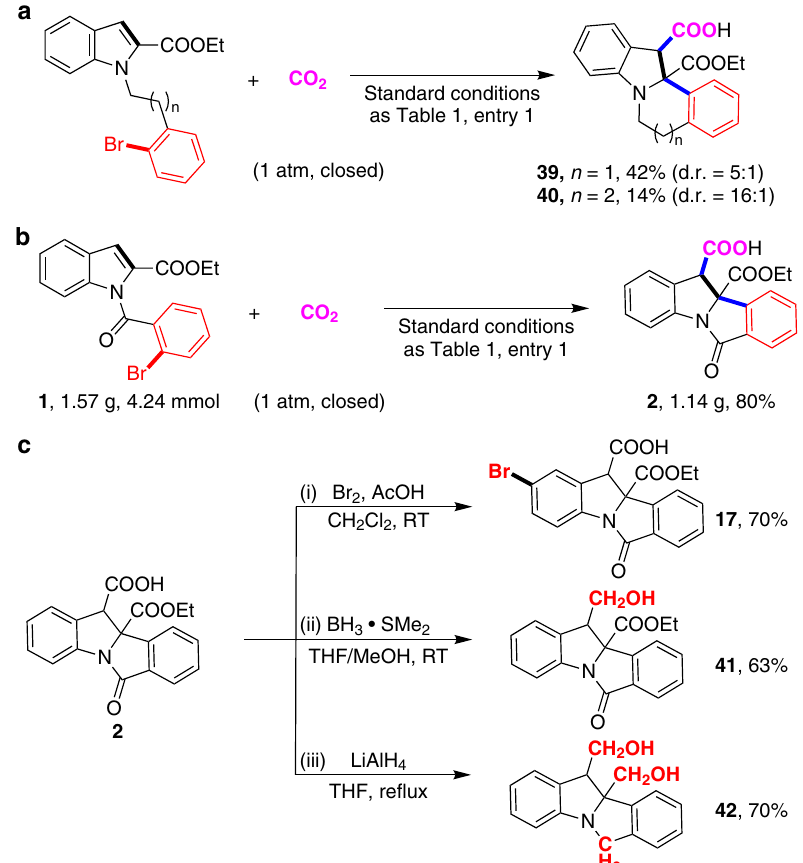
Fig. 5 Synthetic applications. a Synthesis of 6-membered and 7-membered ring-bearing products under the standard conditions. b Gram-scale synthesis of 2 . c Transformations of the product 2 . (i) bromination with Br 2 and AcOH. (ii) selective reduction of the C3-ester group by borane. (iii) reduction of amide and ester groups by LiAlH 4